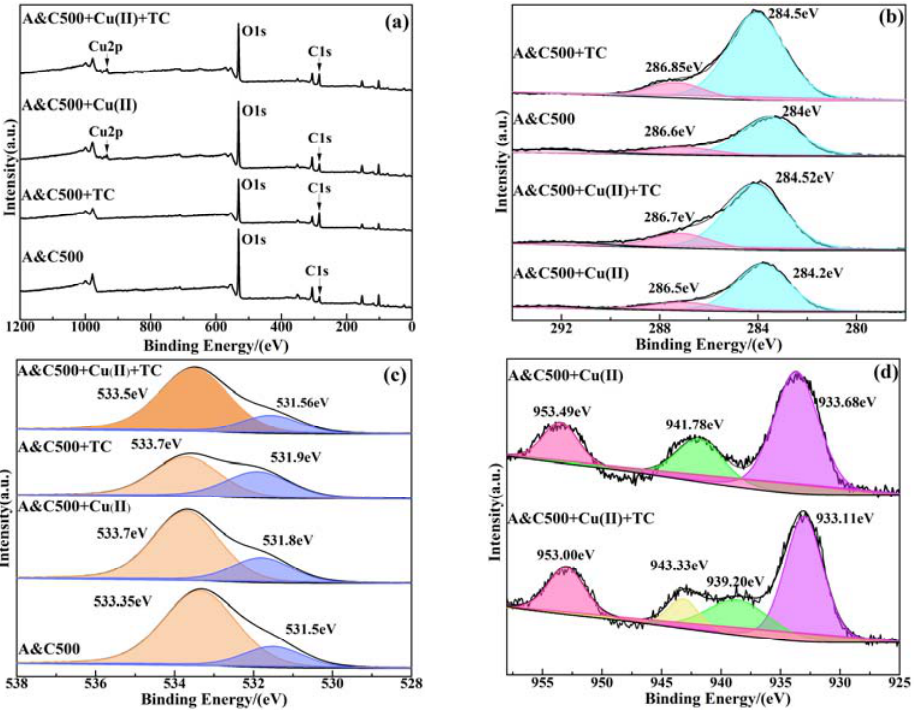
Figure 6. The XPS spectrum of A&C500 before and after adsorbing of TC and Cu(II), ( a ) full-spectrum; ( b ) C1s; ( c ) O1s; ( d ) Cu2p.